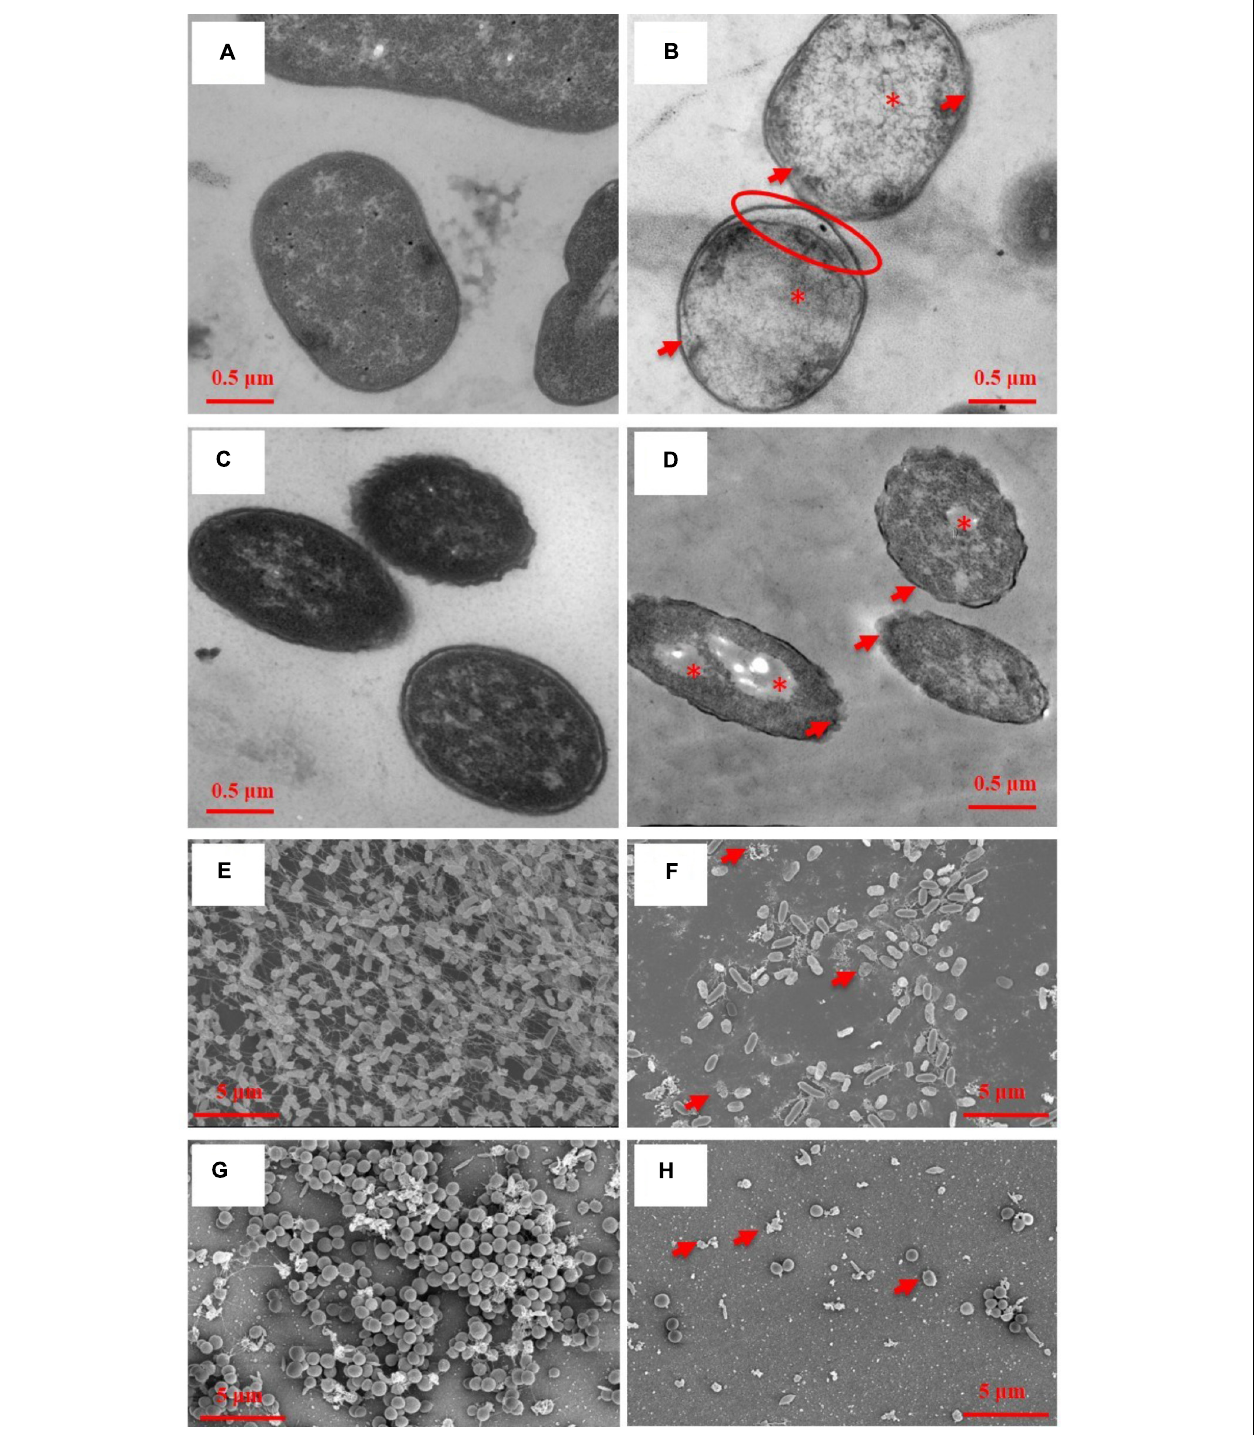
FIGURE 2 | Representative TEM images of planktonic cells (A–D) and SEM images of bacterial biofilms (E–H) with (B,D,E,F) or without (A,C,E,G) oregano oil treatment for 1 h. Oregano oil was used at 0.16 mg/ml for A. baumannii AF0005 cells, 0.56 mg/ml for P. aeruginosa IQ0042 cells, 1.0 mg/ml for P. aeruginosa IQ0042 biofilms, and 0.4 mg/ml for MRSA IQ0064 biofilm. (A,B) A. baumannii AF0005 cells; (C,D) P. aeruginosa IQ0042 cells; (E,F) P. aeruginosa IQ0042 biofilms; and (G,H) MRSA IQ0064 biofilms. Shown are cell wall and membrane damages (B,D; arrows) ; dissociation between cell wall and membrane (B; oval) , cytoplasmic vacuoles and bubbles (B,D; asterisk) , and cell collapse (F,H, arrows) . The number of bacteria was drastically reduced after oregano oil treatment in (F,H) as compared to untreated controls (E,G) .